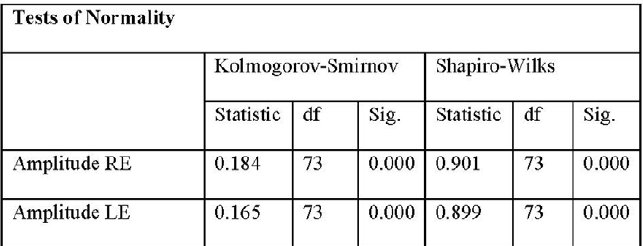
Table 4 Tests of normality for accommodative amplitudes of the right (RE) and left (LE) eyes